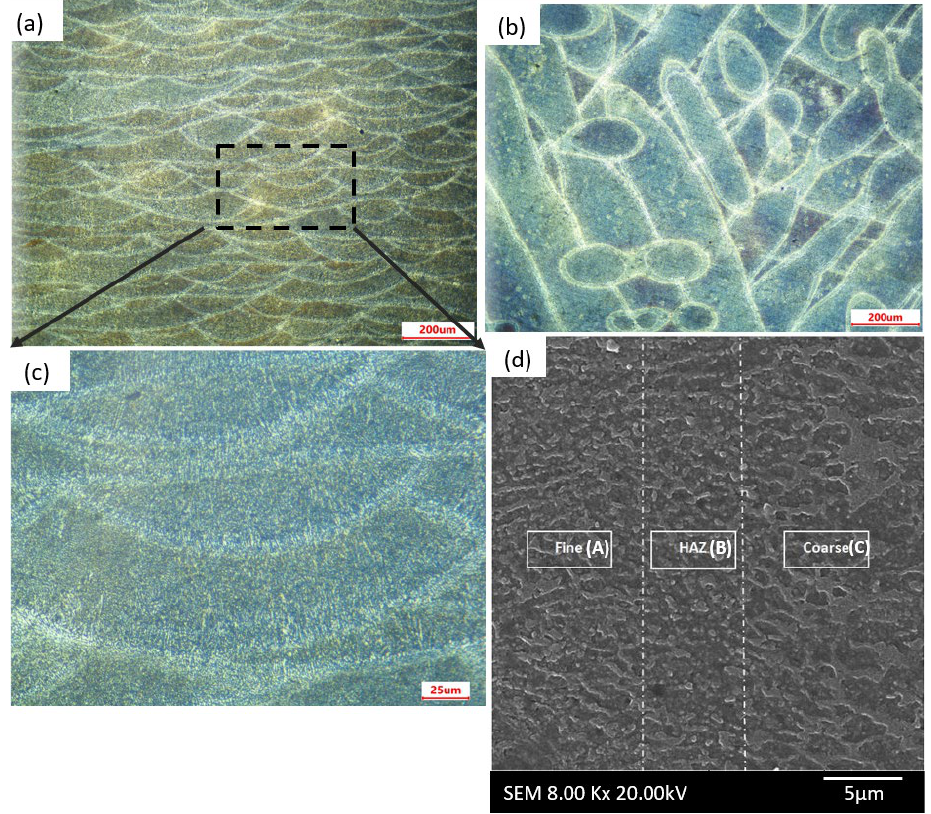
Figure 2. Optical micrographs of as-built AlSi10Mg alloy: ( a ) longitudinal section at low magnification; ( b ) transverse section; ( c ) longitudinal section at higher magnification; ( d ) SEM image of transverse section at higher magnification with heat-affected zones.